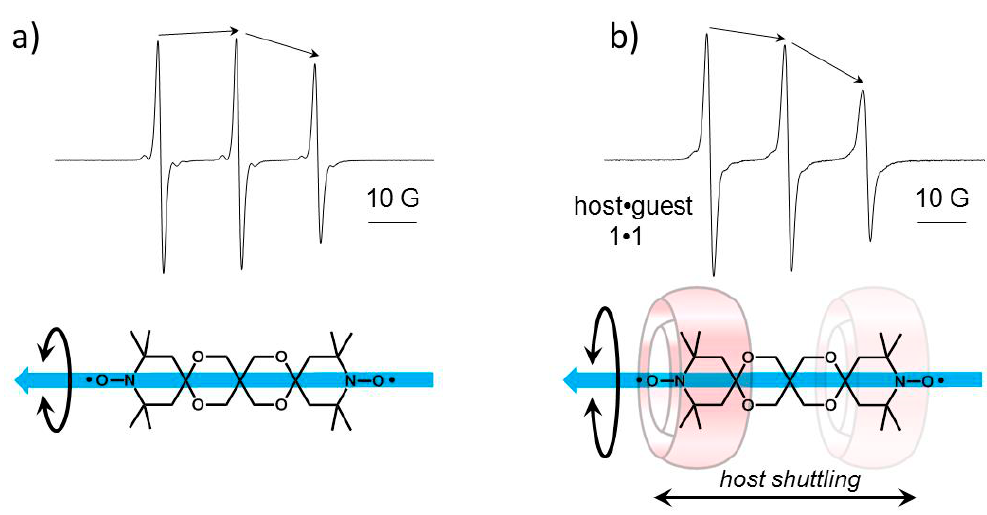
Figure 2. EPR spectra of bTbk (50 µ M) without ( a ) and with CB[8] (1.1 mM, ( b ) and the proposed host position and shuttling based on EPR and NMR (see the text).